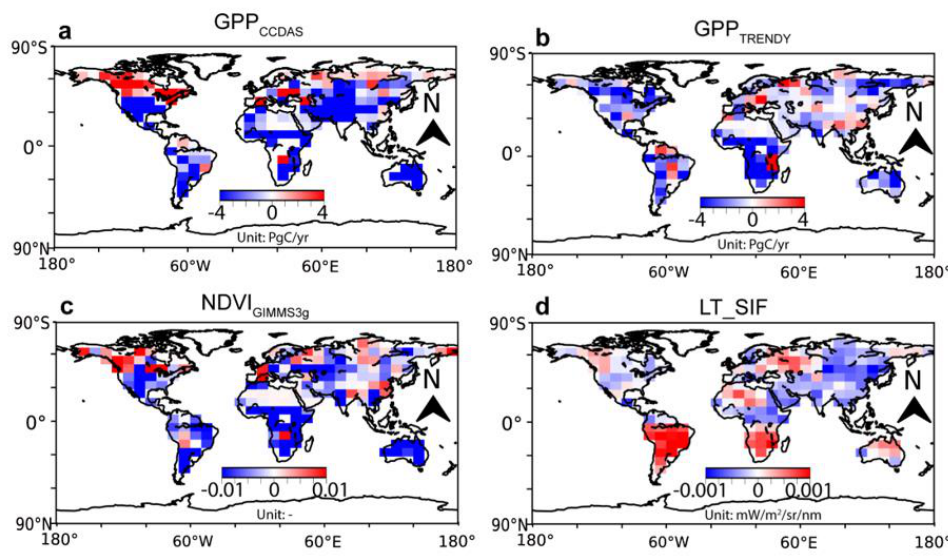
Figure 6. Drought-aggregated GPP from CCDAS, TRENDY, NDVI, and SIF. ( a ), drought-aggregated GPP anomalies for CCDAS from SPEI-9 with SPEI < –1. ( b ), drought-aggregated GPP anomalies for TRENDY multi-model mean (S3, 6 models) from SPEI-9 with SPEI < –1. ( c ), drought-aggregated NDVI for GIMMS3g anomalies from SPEI-9 with SPEI < –1. ( d ), drought-aggregated SIF anomalies for LT_SIF from SPEI-9 with SPEI < –1.